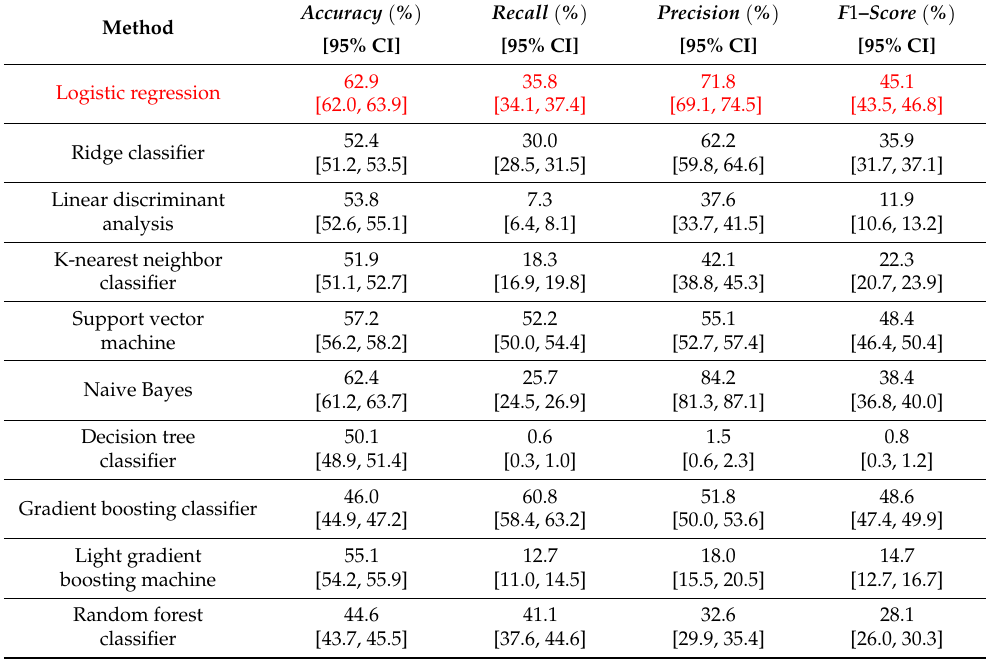
Table 4. Averaged accuracy , recall , precision , and F 1 − score and their 95% confidence interval (CI) of 15 machine learning (ML) methods using hemodynamic features with p -values lower than 0.05 ( A rise,2 and q rise,2 of ∆ RHb, and m rise of − ∆ OHb ) for classification of AD and WT. Each method was performed 600 times by shuffling the data due to limited data sets. The results and the name of the ML method with the best accuracy (logistic regression) are highlighted in